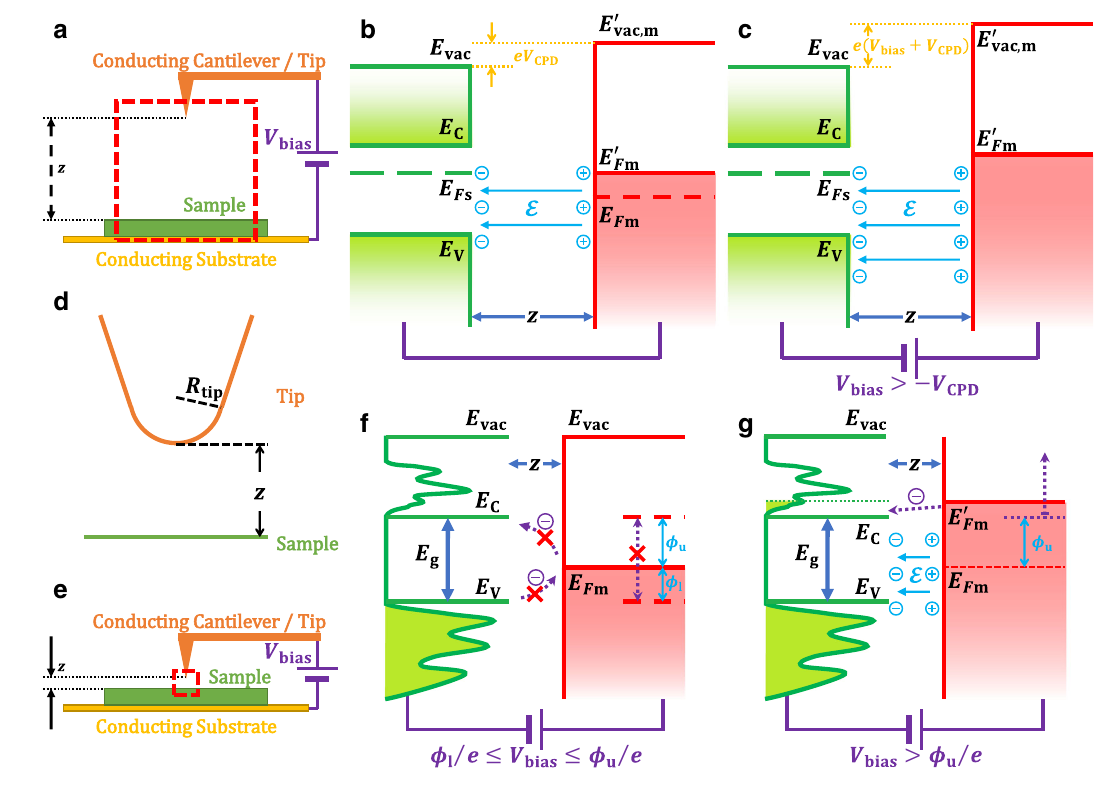
Fig. 1 | Working principle of localized electric force microscopy (LEFM). a The schematic diagram of the regular electric force microscopy (EFM). Here V bias is the scanning externalbiasvoltageand z isthetip-sampleseparation. b Theenergylevel alignment between the conductive tip and the sample at the regular EFM without bias( V bias =0).Here E vac , E C , E F s ,and E V denotethevacuumlevel,conductionband edge, Fermi level, and valance band edge of the sample, respectively. The charge transfer between the sample and tip aligns the Fermi level E F m and consequently twists the Fermi level to E 0 F m and vacuum level to E 0 vac,m by the amount of contact potential difference V CPD , and builts up a local electric fi eld E between the samples and the tip. c The energy alignment between the tip and the sample under